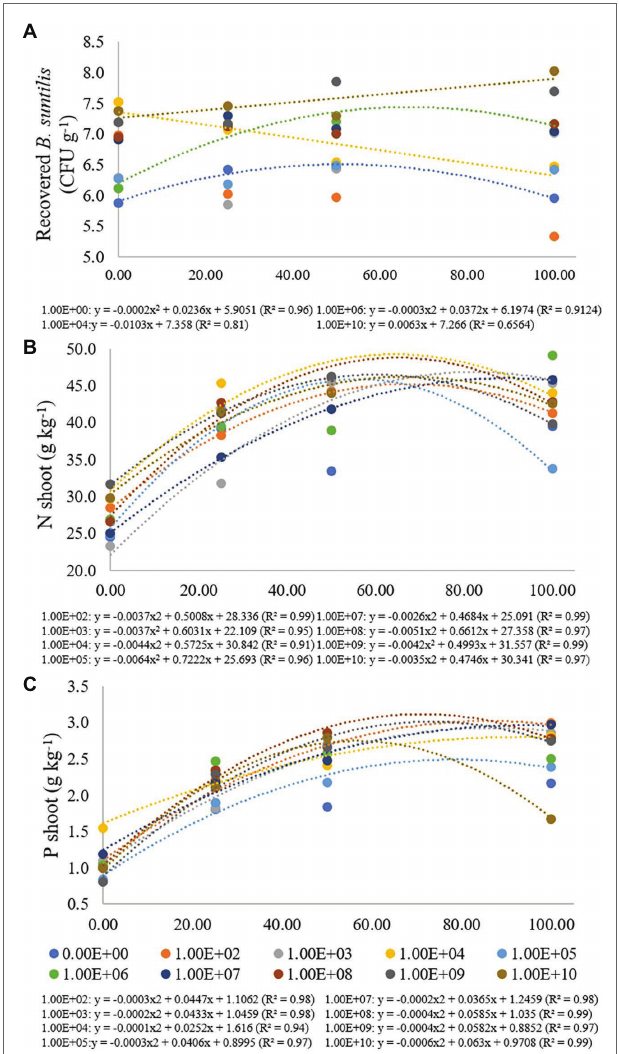
FIGURE 2 | Regression data for the unfolding of the interaction between inoculum concentrations and fertilization doses in relation to the concentration of (A) B. subtilis recovered from roots (CFU g − 1 ); (B) nitrogen (g kg − 1 ) and (C) phosphorus (g kg − 1 ) concentration in soybean plant shoots. The X-axis indicates fertilization dose in percentage—colored circles and the equation— 0.00E+00 means no inoculation (control); 1.00E+02 means 1 × 10 2 CFU ml − 1 ; 1.00E+03 means 1 × 10 3 CFU ml − 1 ; 1.00E+04 means 1 × 10 4 CFU ml − 1 ; 1.00E+05 means 1 × 10 5 CFU ml − 1 ; 1.00E+06 means 1 × 10 6 CFU ml − 1